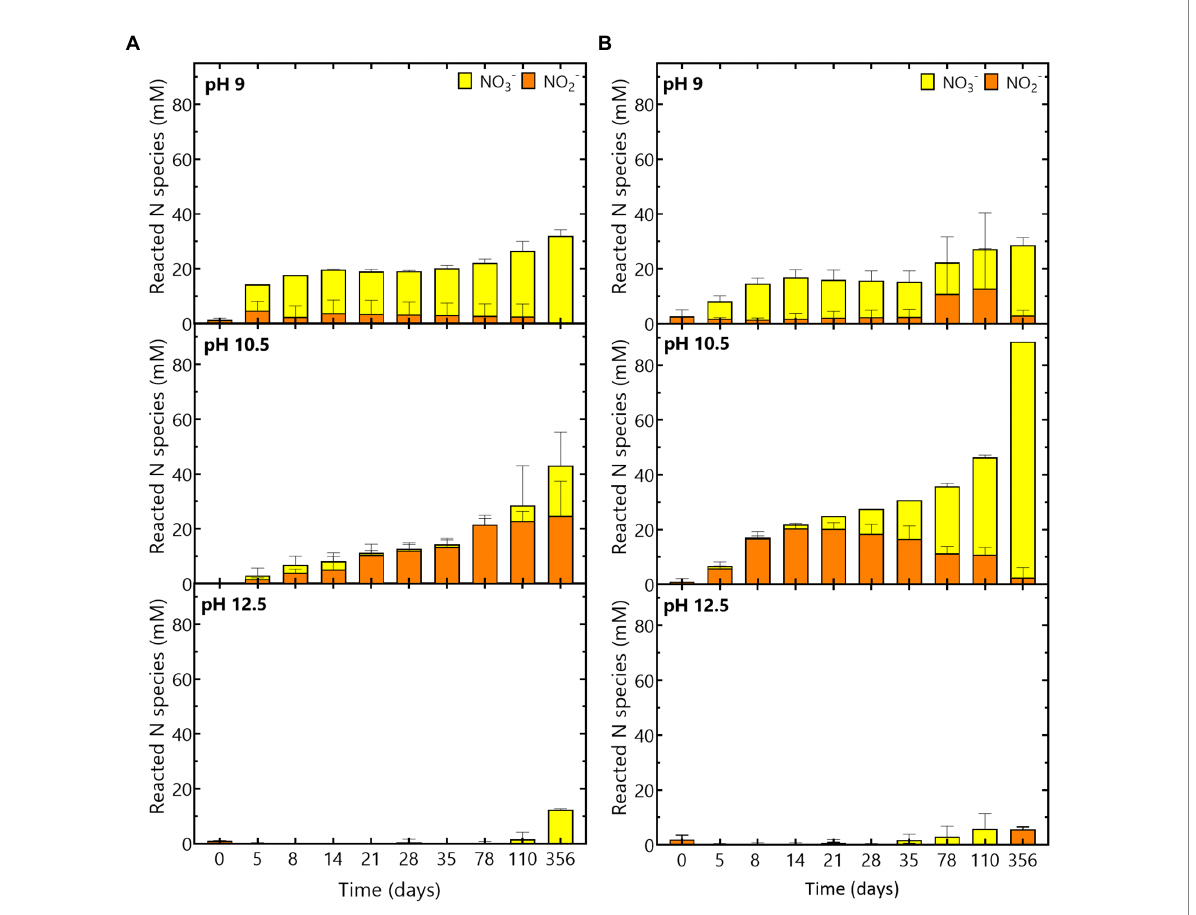
FIGURE 4 Evolution of the reacted N species (NO 3 − and NO 2 − ) during the experiment at pH 9, pH 10.5 and pH 12.5 for (A) the Boom Clay borehole microbial community and (B) the Harpur Hill sediment. NO 3 − concentrations are given in yellow and NO 2 − concentrations are shown in orange. Values represent the average and standard deviation of three replicates except for day 356 and abiotic samples of pH 9 and pH 10.5 where the result of two replicates is